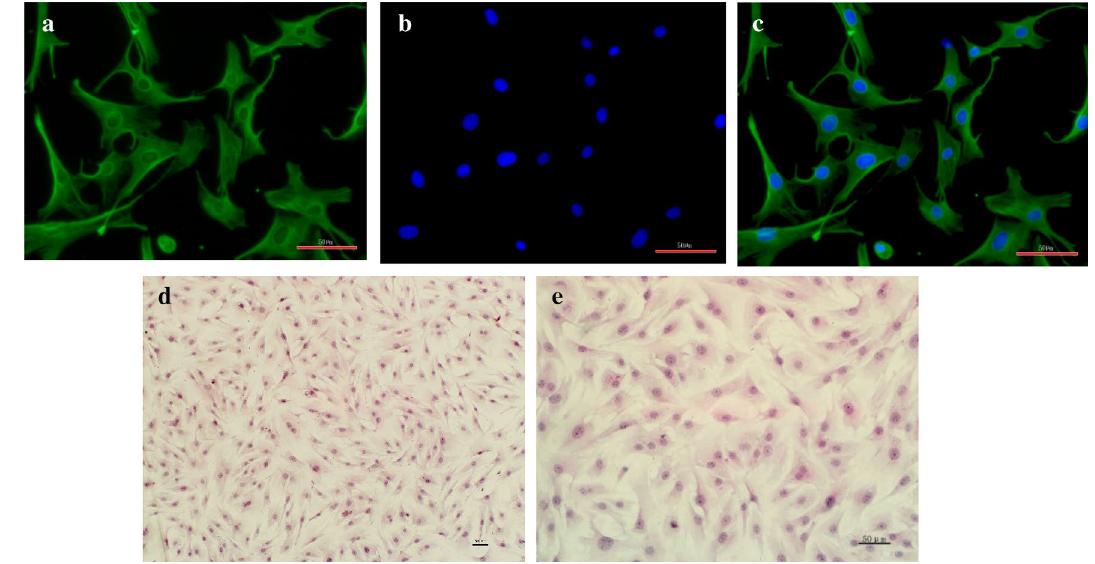
Figure 1. Morphology of primary isolated dairy cow claw dermal cells. ( A ) Cytoplasm was detected of vimentin expression (green); ( B ) Nucleus was stained with DAPI (blue); ( C ) Merge A and B; ( D , E ) HE staining. (scale = 50 μm).